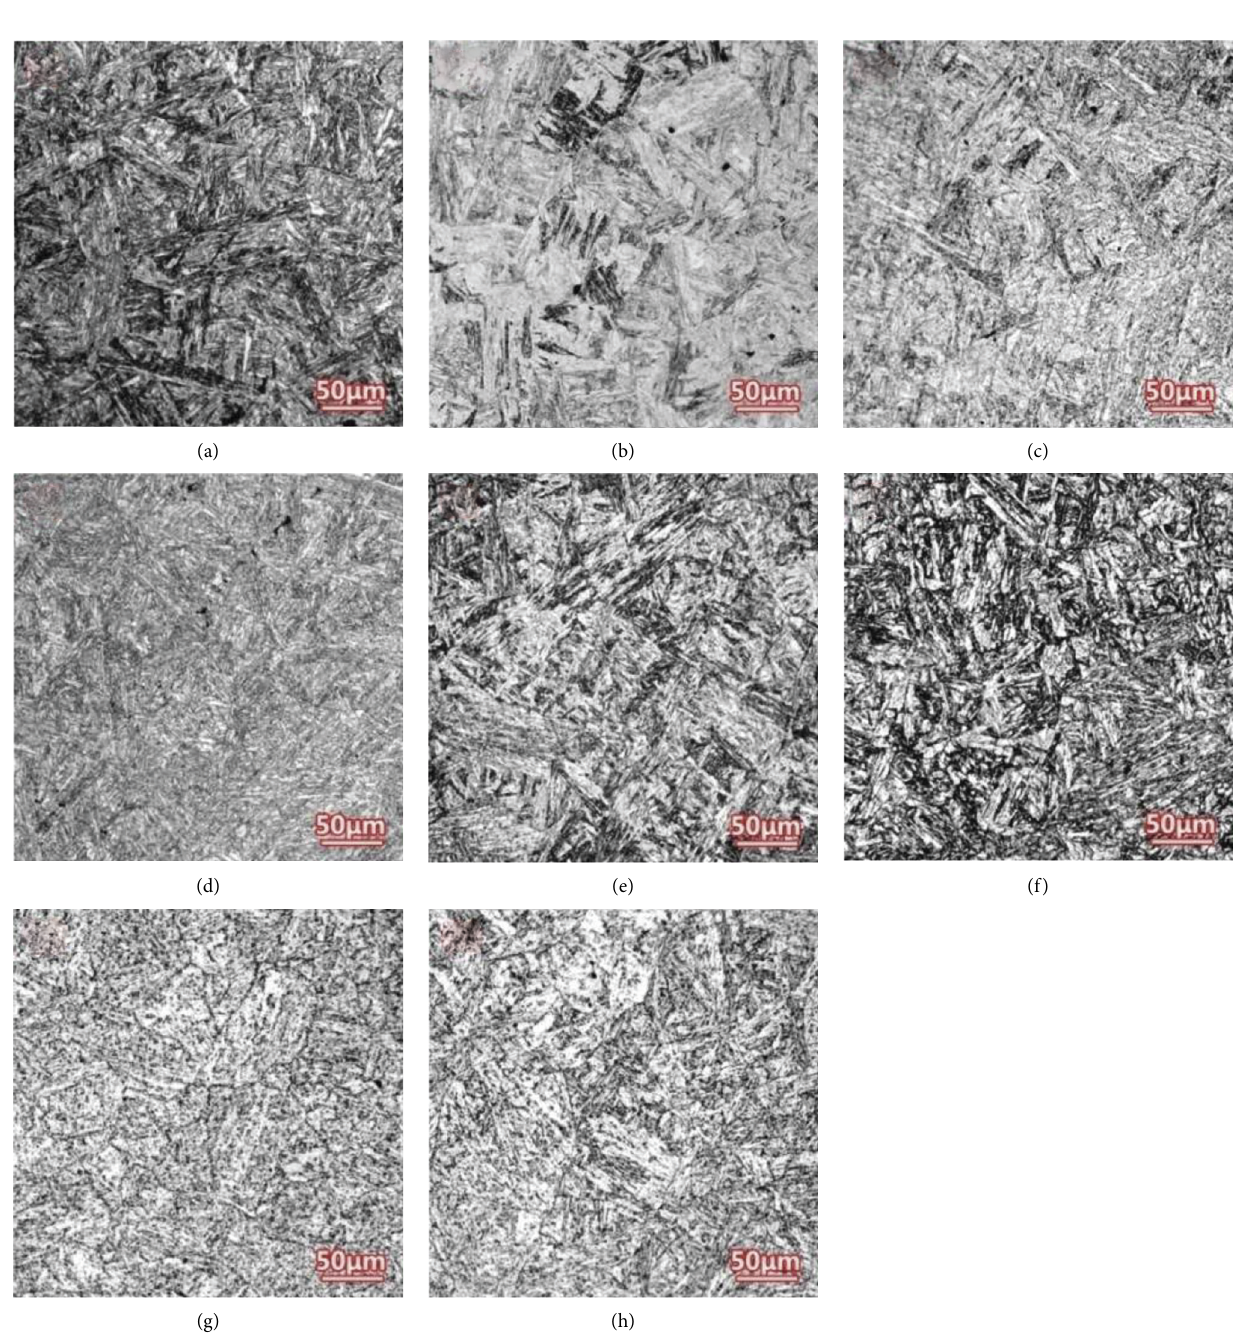
Figure 3: OM images of the evolution of G115 steel aged at 650 ° C (a–d) and 700 ° C (e–h) for (a, e) 500 ° h, (b, f) 1000 ° h, (c, g) 3000 ° h, and (d, h)